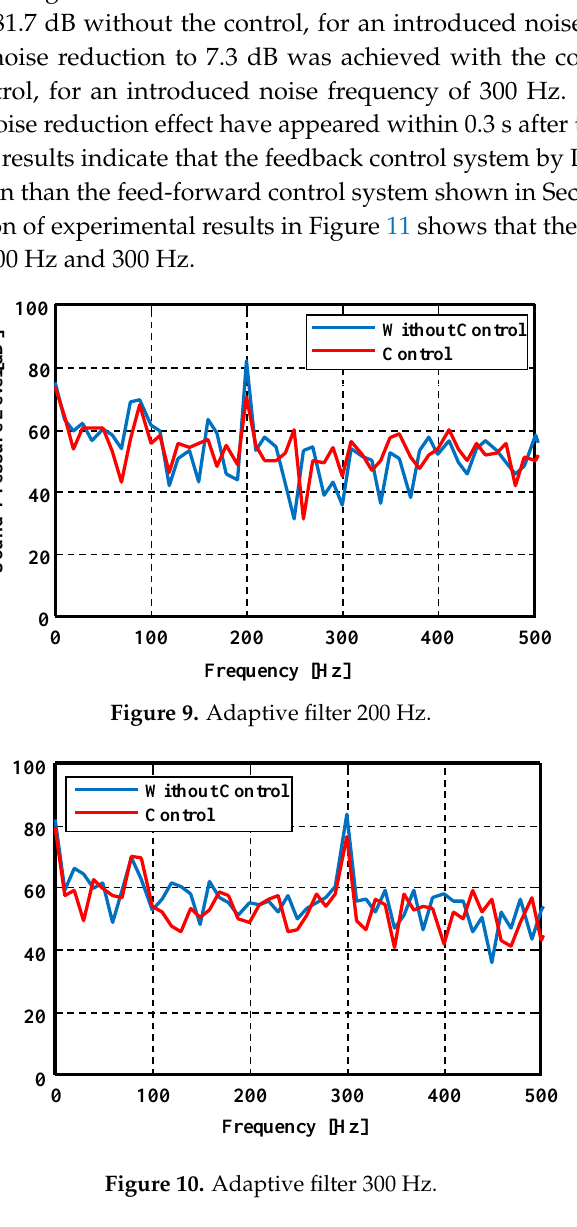
Figure 10. Adaptive filter 300 Hz.